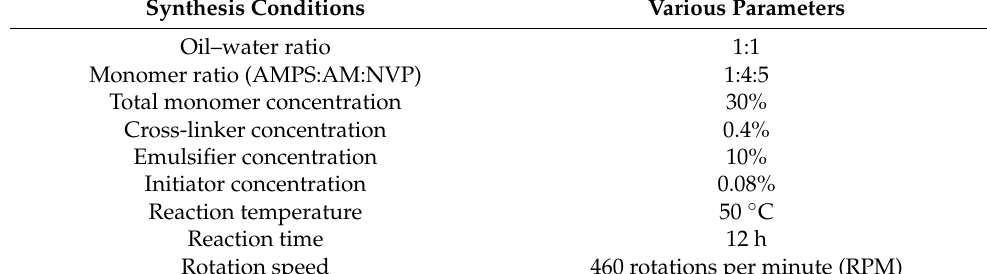
Table 1. The synthesis conditions of AMN other than HLB.